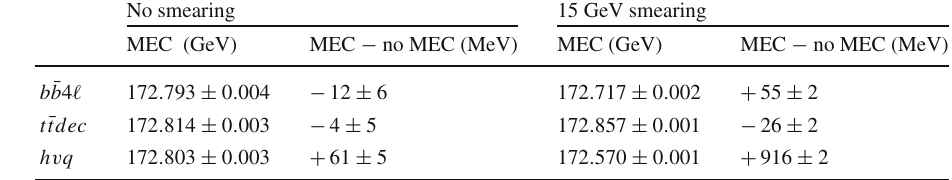
Table 3 Differences in the m Wb peak position for j m t =172.5 GeV for t ¯ tdec and h v q with respect to b ¯ b 4 (cid:4) , showered with Pythia8.2 , at the NLO+PS level and at the full hadron level